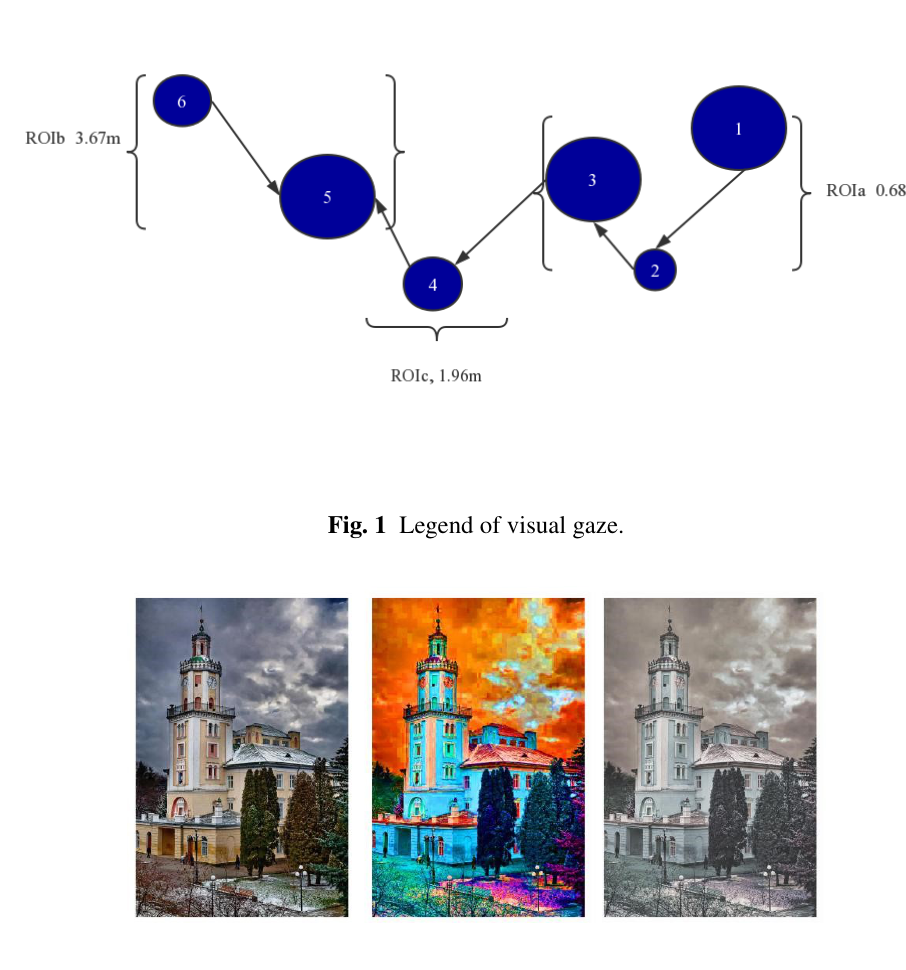
Fig. 2 Time to target